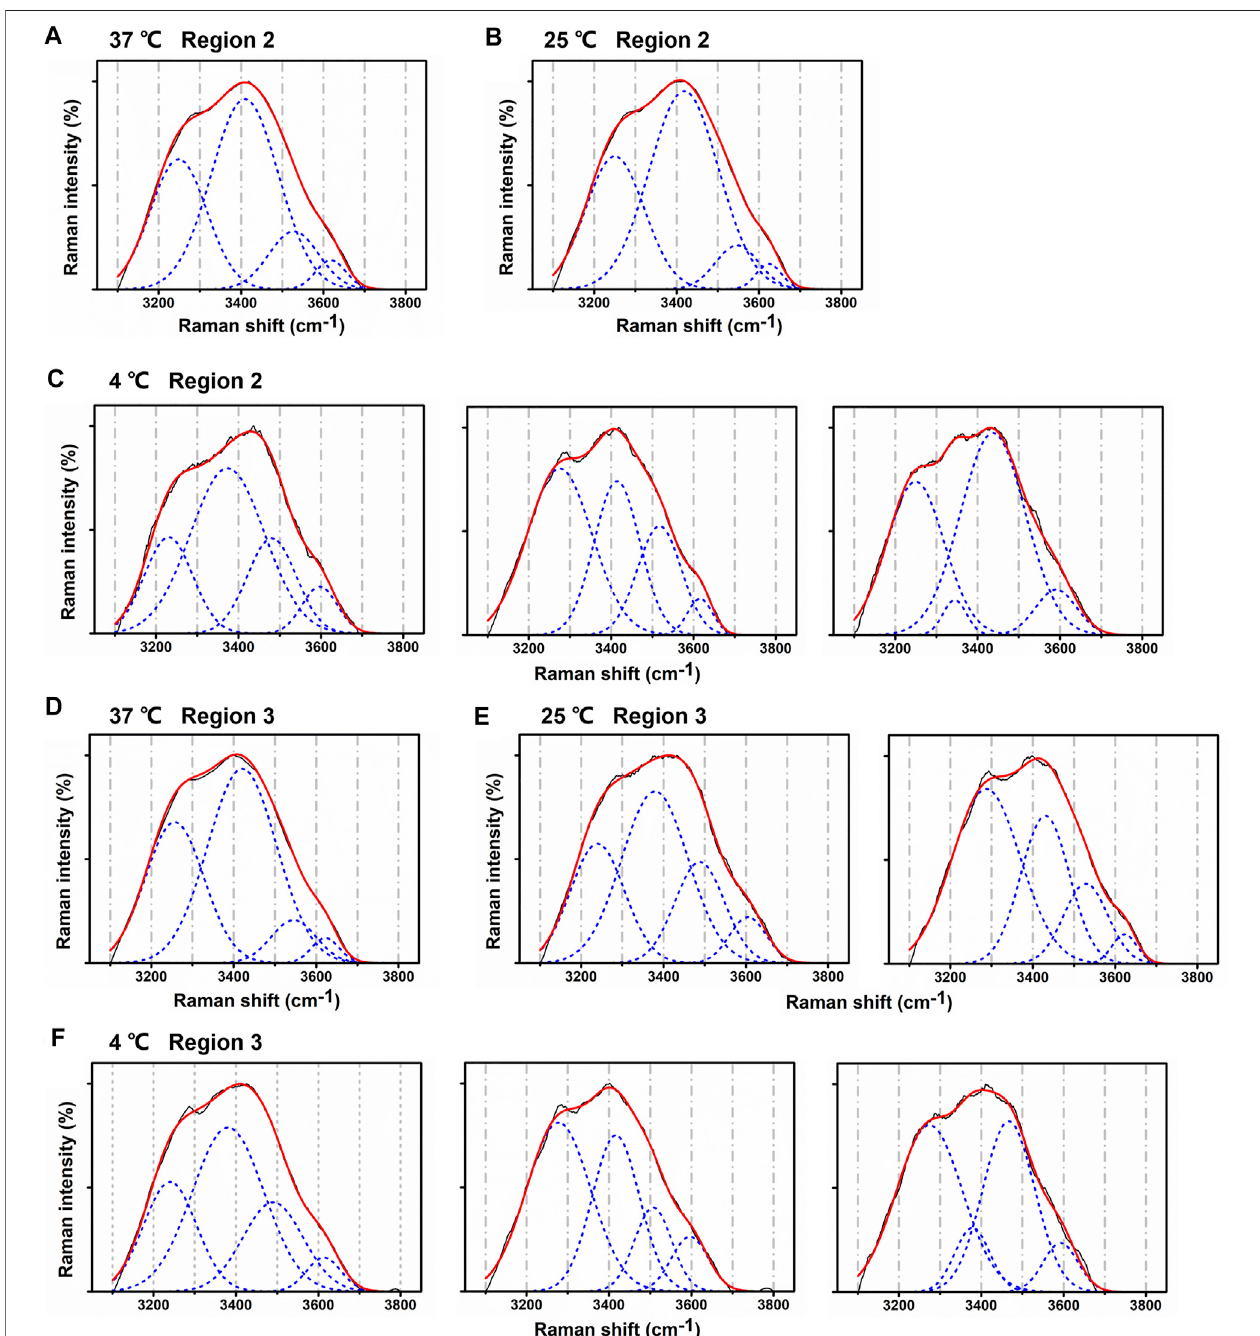
FIGURE6| ChangesinGaussianpeaksfromregions2and3atdifferenttemperatures. (A – C) TypicalGaussianpeaksfromregion2at37 ° C,25 ° C,and4 ° C. (D – F) Typical Gaussian peaks from region 3 at 37 ° C, 25 ° C, and 4 ° C.